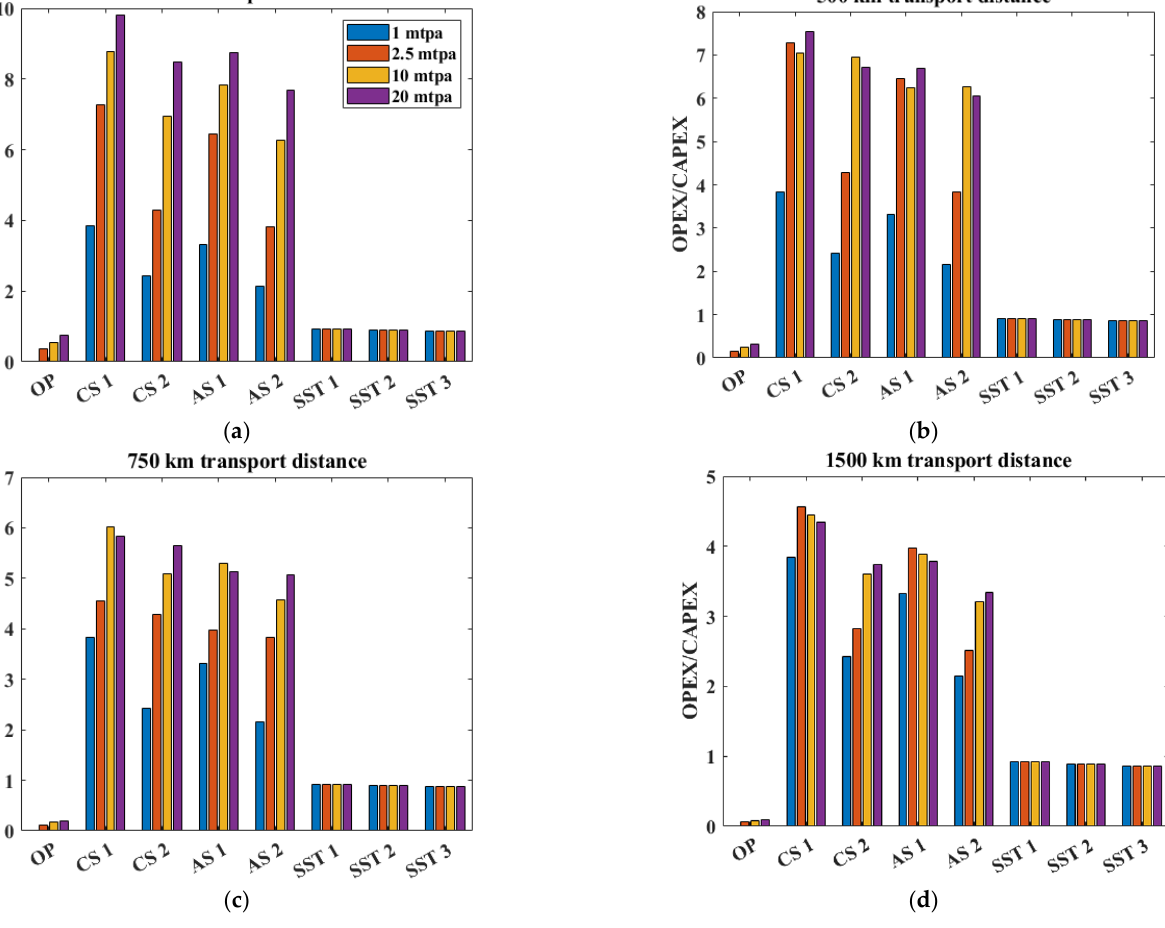
Figure 10. CAPEX and OPEX ratio on different source volumes and transport distances: ( a ) 180 km; ( b ) 500 km; ( c ) 750 km; ( d ) 1500 km.